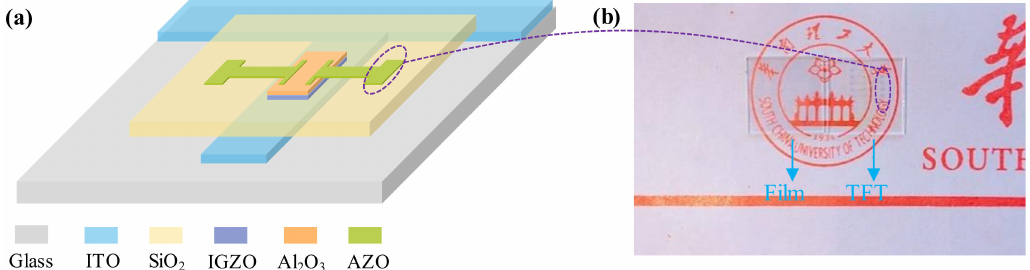
Figure 1. ( a ) Schematic illustration of the transparent TFTs with AZO S/D electrodes; ( b ) digital photo of transparent AZO film and corresponding